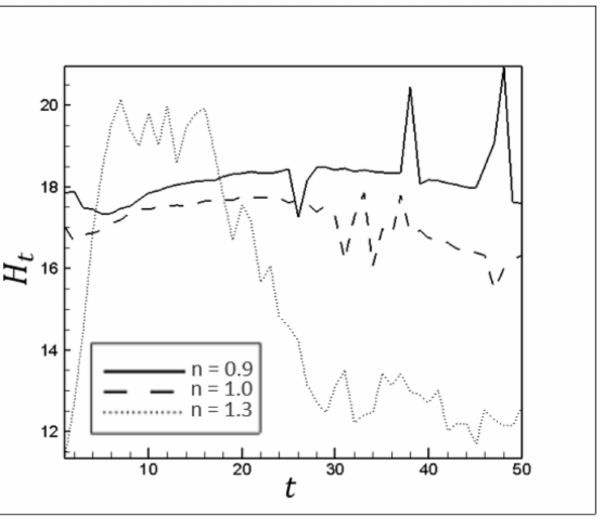
Figure 16. The mean thickness of the static layer at the top of the channel, H t , over time for different n.